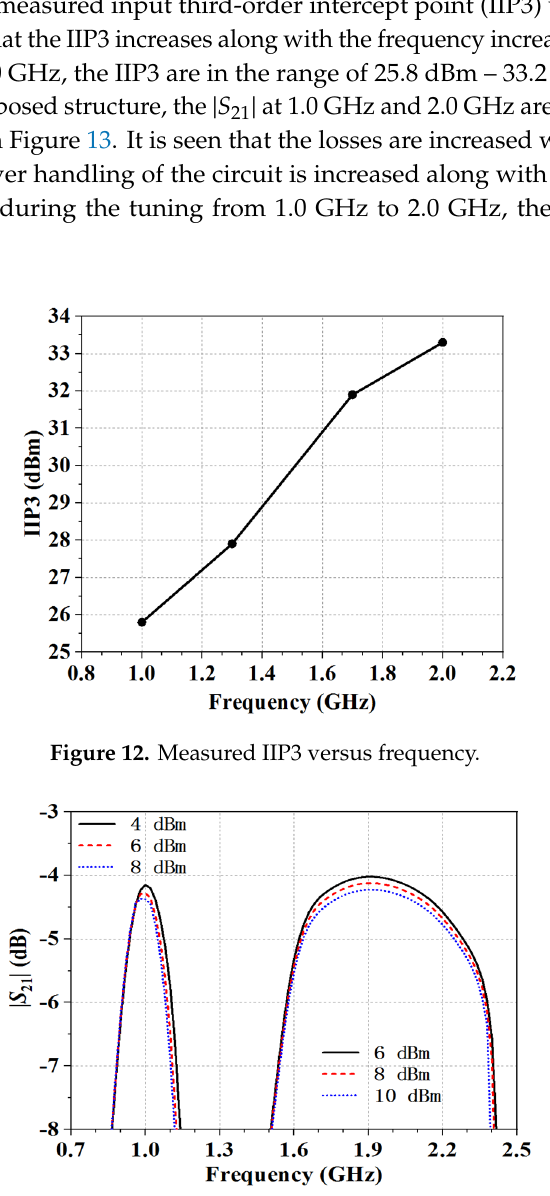
Figure 13. Measured | S 21 | for different input powers at 1.0 GHz and 2.0 GHz.